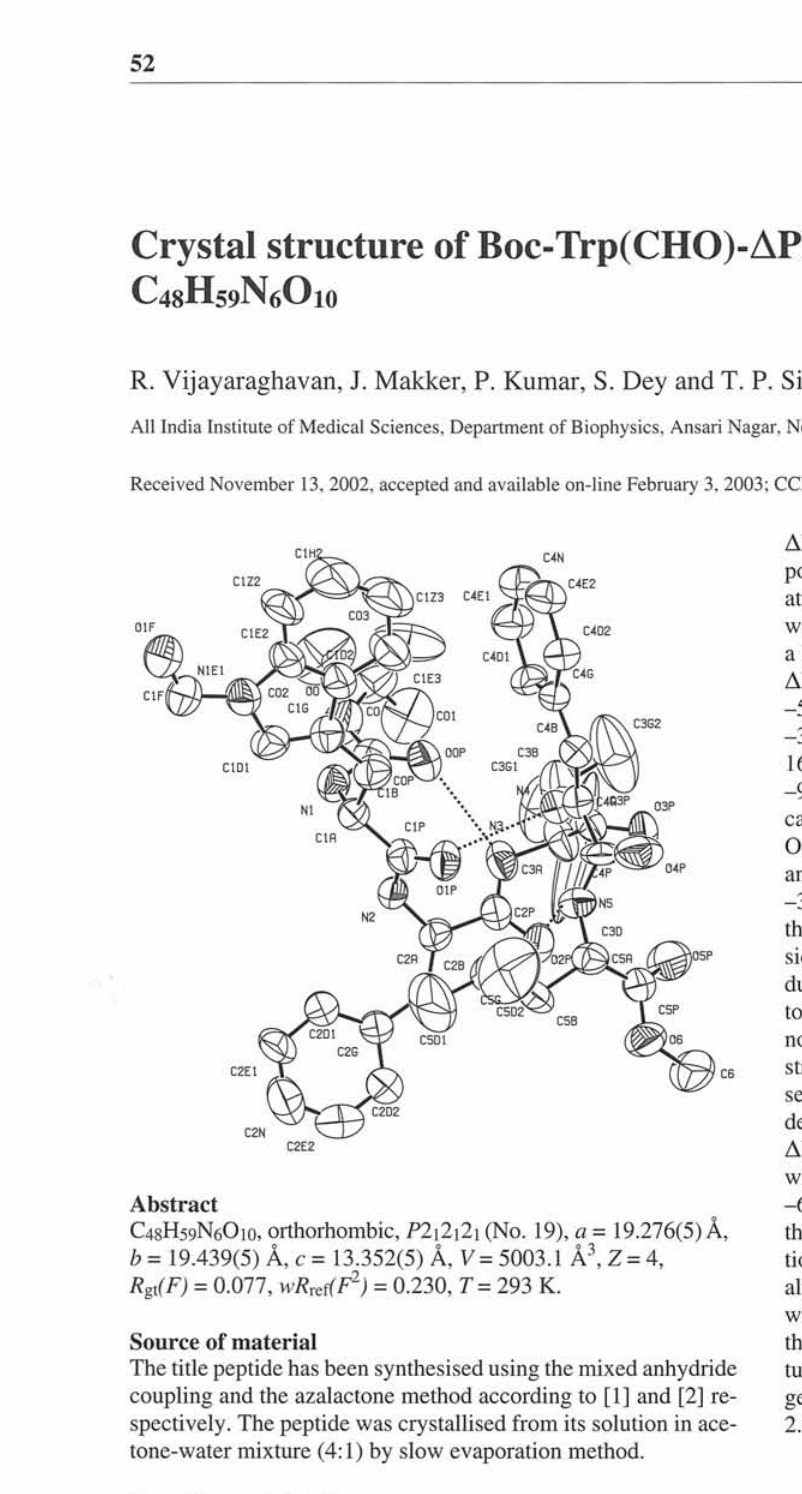
Table 1. Data collection and handling.